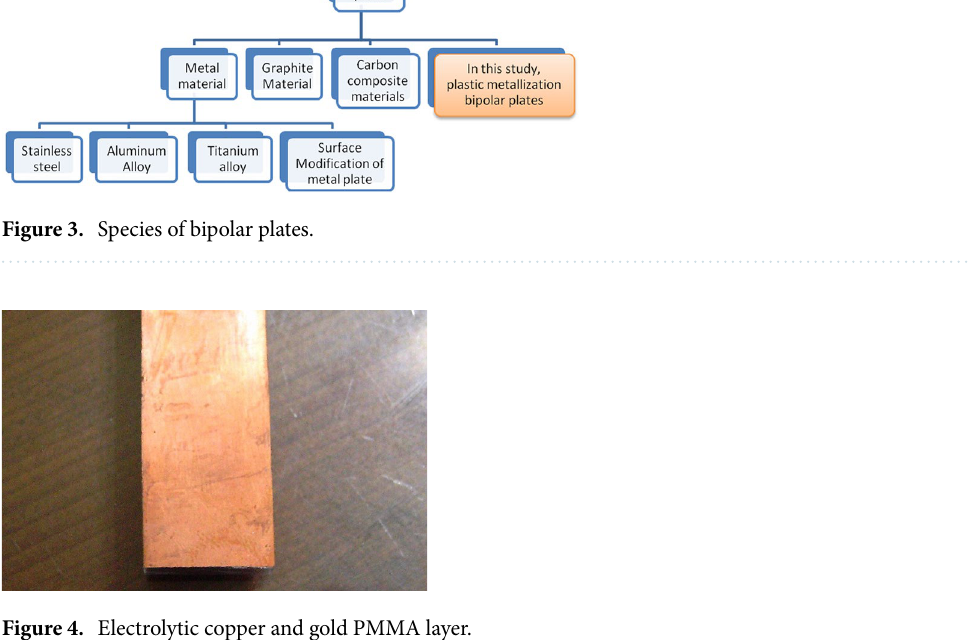
Figure 4. Electrolytic copper and gold PMMA